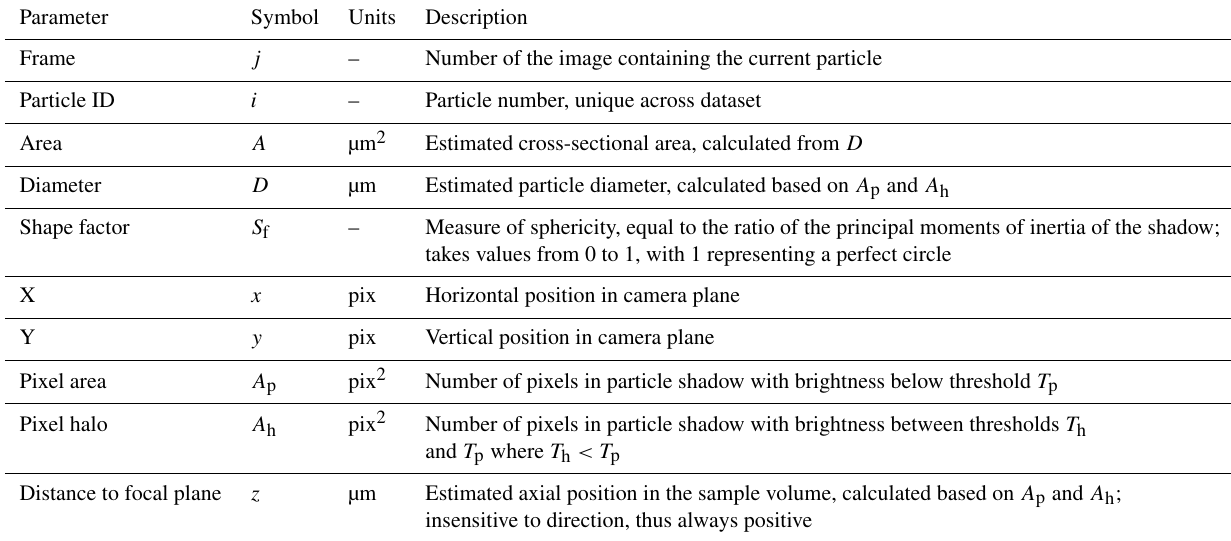
Table 2. Explanation of the parameters reported in the output droplet file together with the symbols used to denote them in the text. Parameter Symbol Units